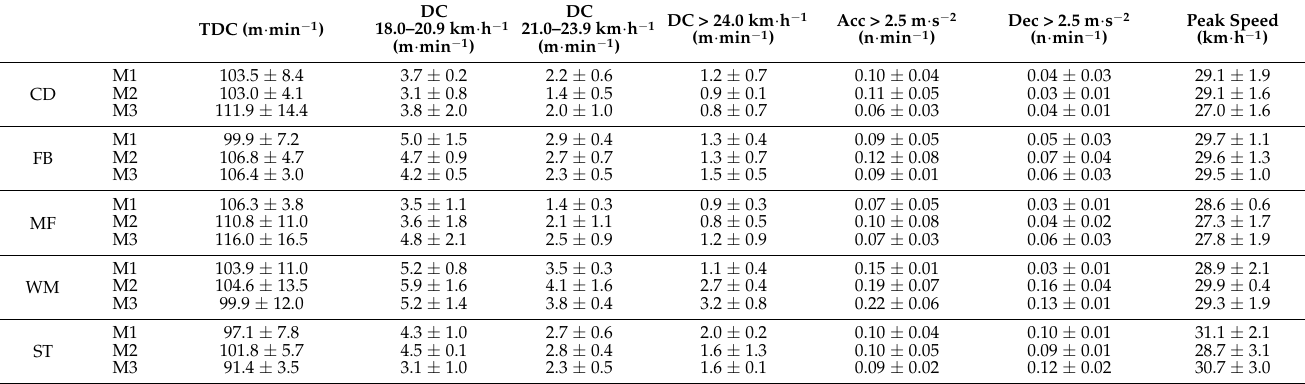
Table 2. External load during the three matches in a congested fixture according to the playing position.